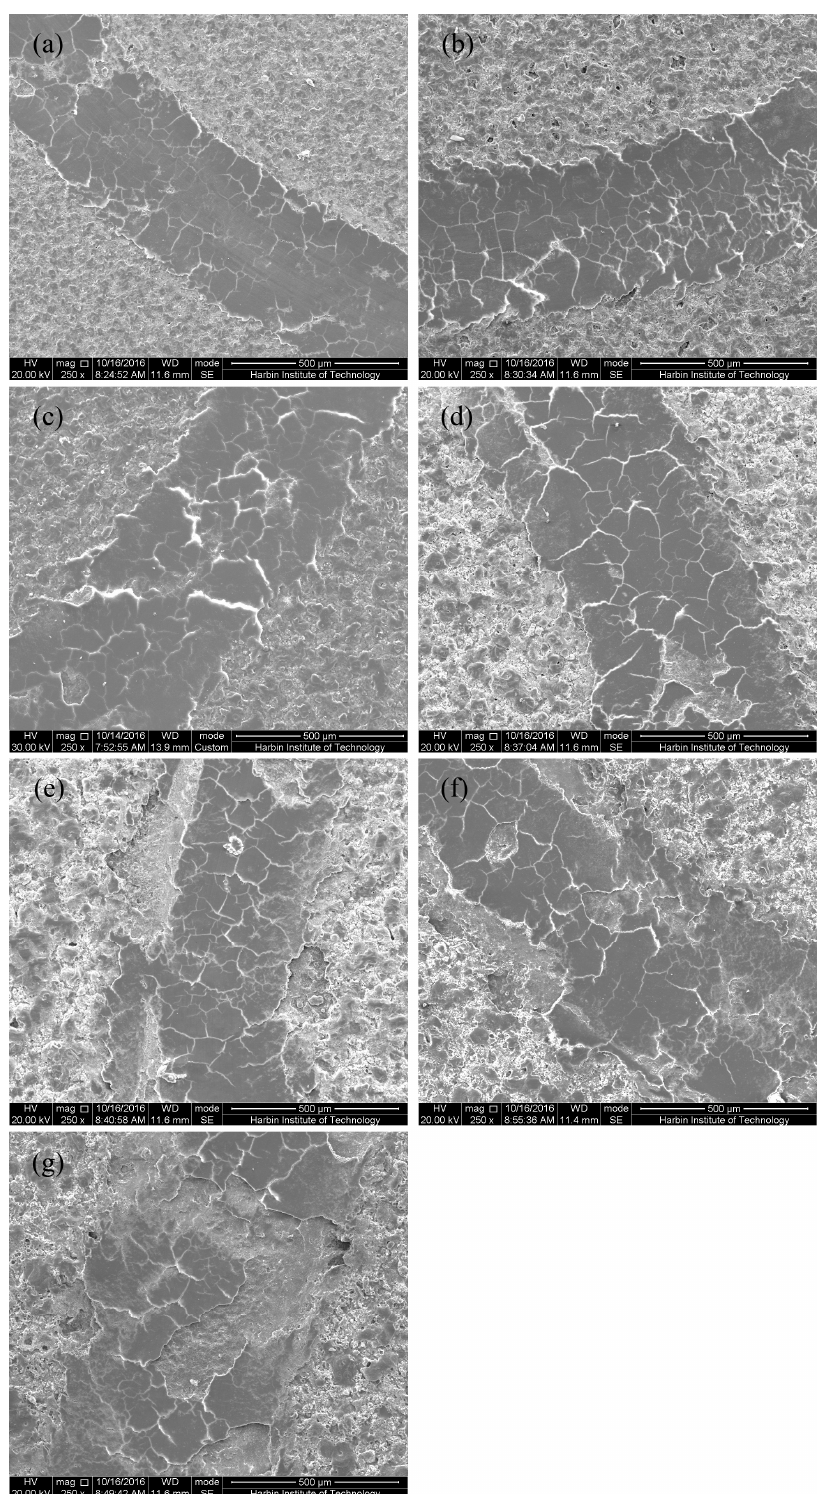
Figure 14. The morphologies of wear tracks for the microarc oxidation coatings formed on aluminum alloys at different anode pulse-widths. ( a ) 1000 μ s; ( b ) 1500 μ s; ( c ) 2000 μ s; ( d ) 2500 μ s; ( e ) 3000 μ s; ( f ) alloys at different anode pulse-widths. ( a ) 1000 µ s; ( b ) 1500 µ s; ( c ) 2000 µ s; ( d ) 2500 µ s; ( e ) 3000 µ s; 3500 μ s; ( g ) 4000 μ s. ( f ) 3500 µ s; ( g ) 4000 µ